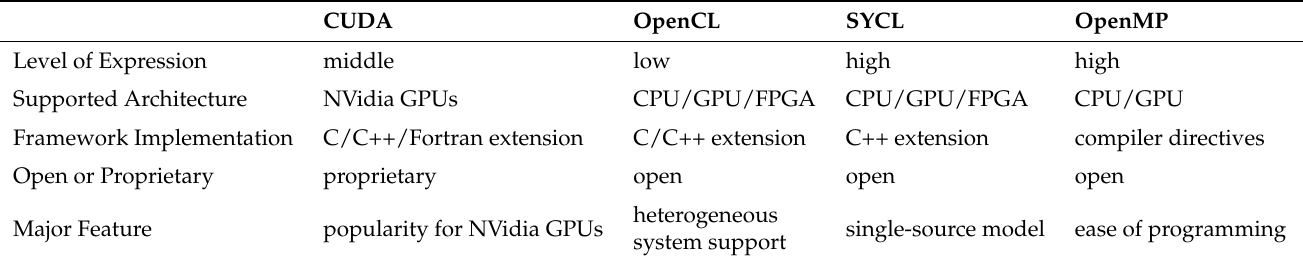
Table 1. Comparison of programming models for HPC on